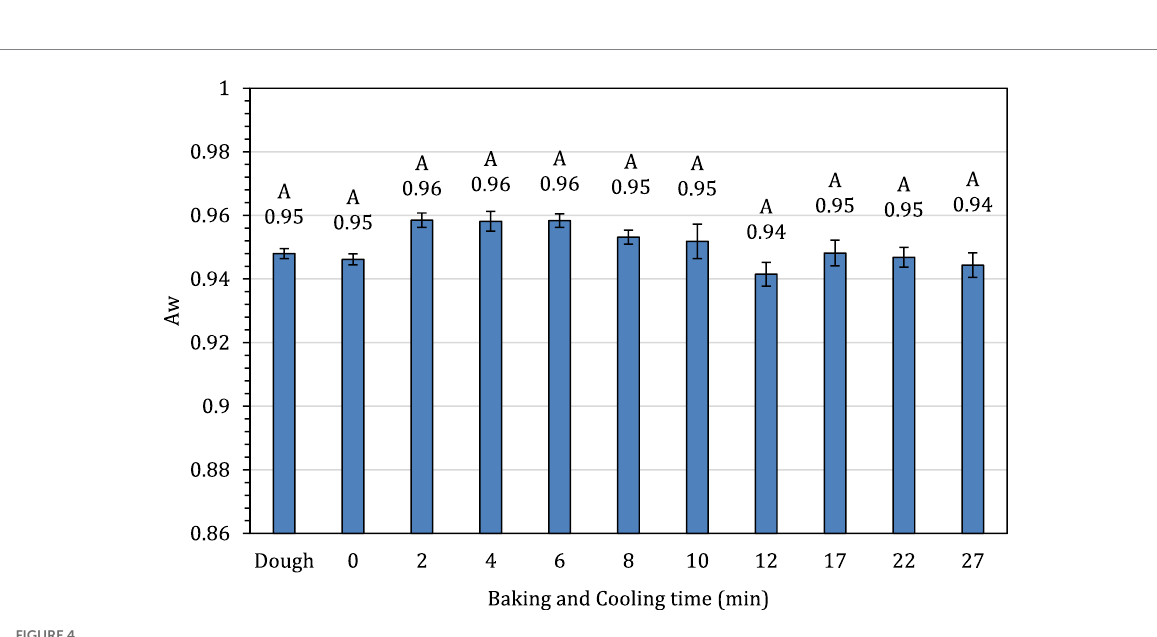
FIGURE 4 The water activity of pizza samples during 12 min of baking followed by 15 min of ambient